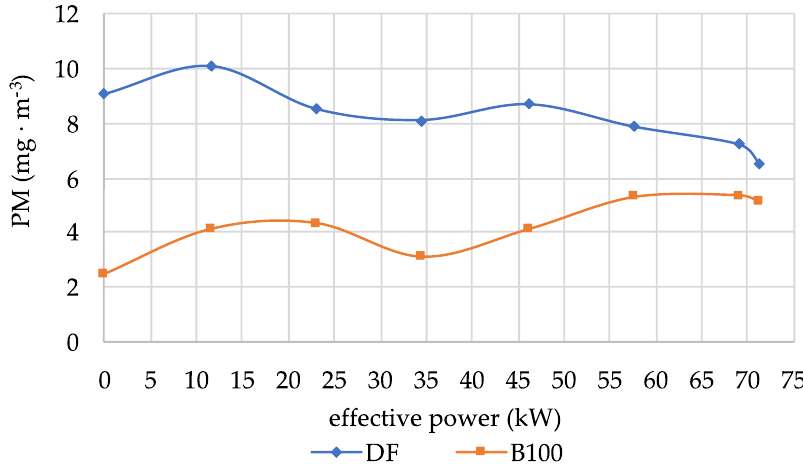
Figure 9. PM emissions vs. the effective power of the John Deere 4045TF285JD engine at 2150 rpm.